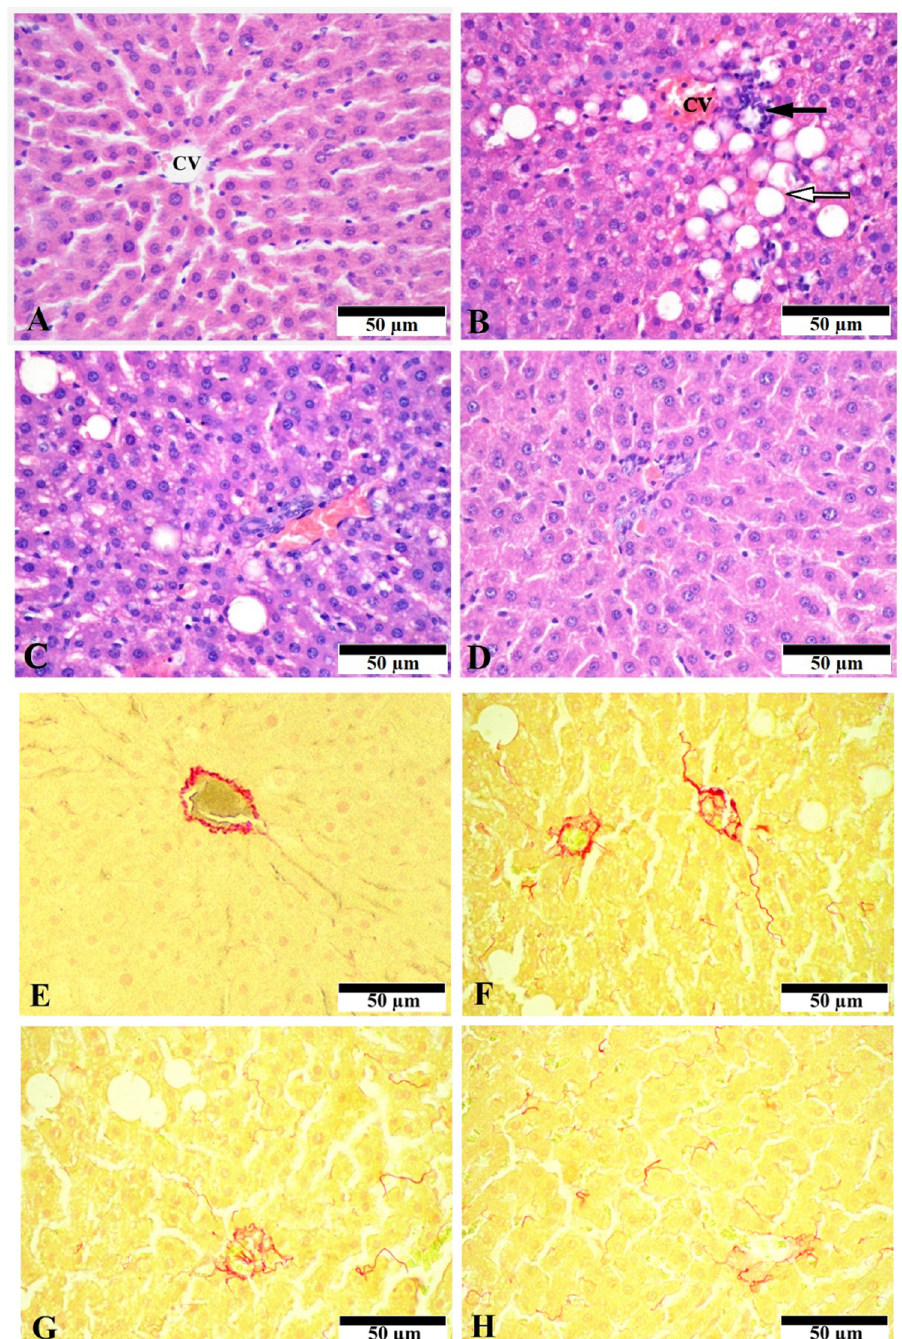
Figure 1. Representative photographs of liver slides. ( A – D ): Staining with haemotoxylin and eosin, original magnification × 400. ( A )—Control group showed the normal liver architecture, cell structure, and central vein (CV) with no abnormalities; ( B )—Alcohol-treated group (ASH). Macrovesicular fatty dystrophy (white arrow) and inflammatory foci in the ASH group (black arrow); ( C )—ASH + CGA, 40 mg/kg; ( D )—ASH + CGA, 80 mg/kg. In the groups treated with CGA, mainly microvesicular steatosis and scattered lymphoid infiltration were seen. ( E – H ): Staining with Sirius Red, original magnification × 400. ( E )—Control group with no abnormalities. Connective tissue was observed only in the walls of major blood vessels and hepatic capsule. ( F )—Alcohol-treated group (ASH). Moderate collagen deposition around central veins and portal areas. ( G )—ASH + CGA, 40 mg/kg; ( H )—ASH + CGA, 80 mg/kg. The decrease of collagen deposition.